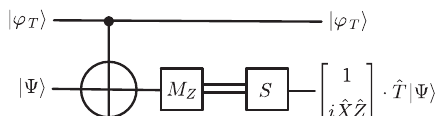
FIG. 11. S - and T - gate ancilla preparation . We create the j φ and j φ ancilla states, which are needed to realize logical S and T i T gates by preparing the short qubit [28] shown above. We cease stabilizer measurements on two adjacent plaquettes p and q . In the next surface code cycle, we perform a rotation of the two-level system defined by i γη . Finally, we enlarge the logical qubit by extending one end of the qubit to guarantee stability against